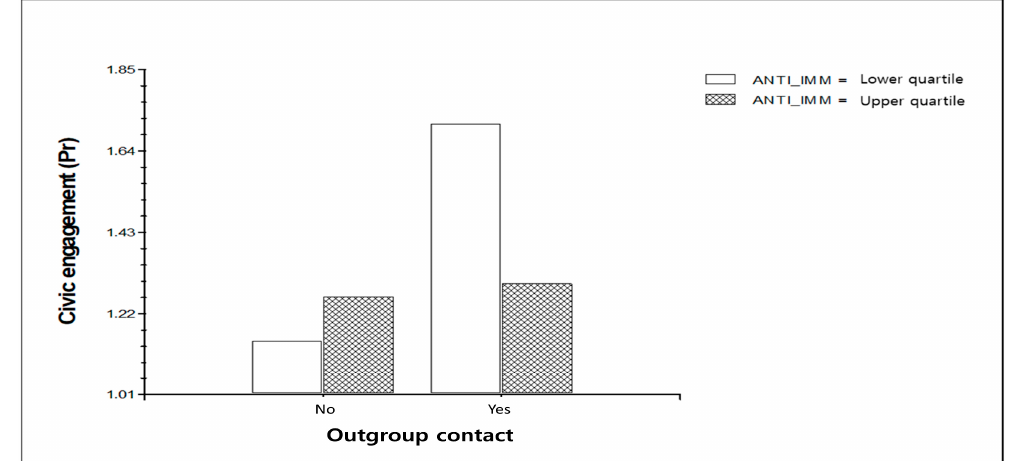
Figure 1. Predicted civic engagement as a function of intergroup contact and regional of level anti-immigrant attitude (at lower and upper quartiles).